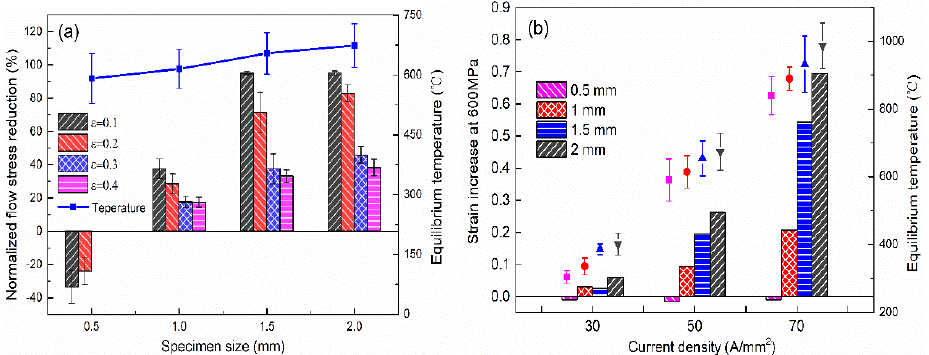
Figure 7. ( a ) Normalized flow stress reduction with different specimen sizes under 50 A/mm 2 and ( b ) the strain increment with different specimen sizes under different current densities.